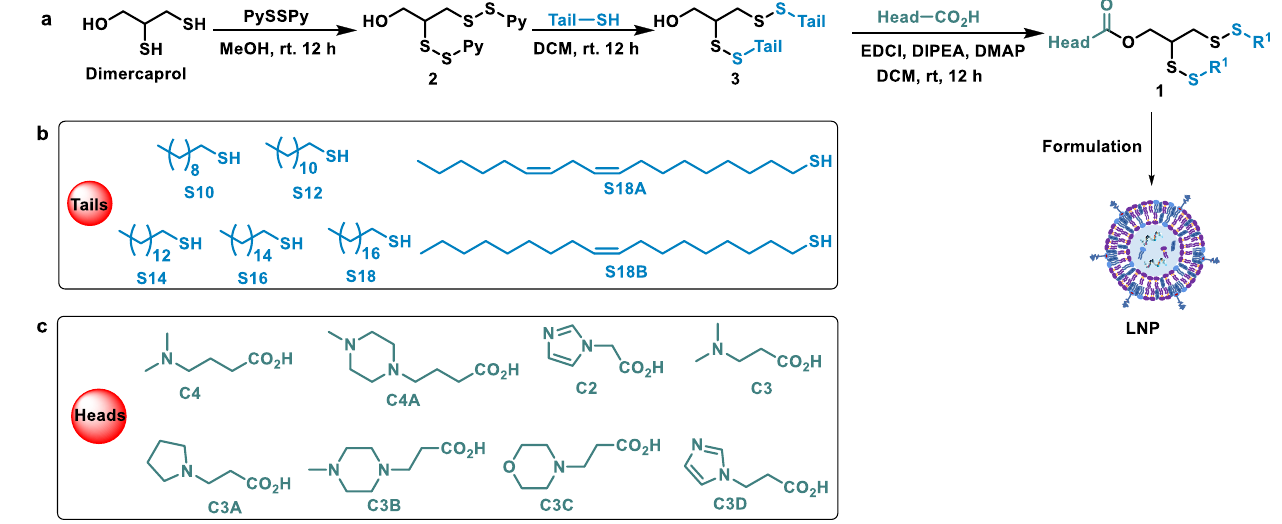
Figure 2. Construction of disulfide lipids library. ( a ) Synthetic route for the preparation of disulfide lipids. ( b ) Hydrophobic tails used in the lipids. ( c ) Hydrophilic heads used in the lipids. The heads and the tails were termed as C and S, and the numbers behind them refer to the number of carbons.